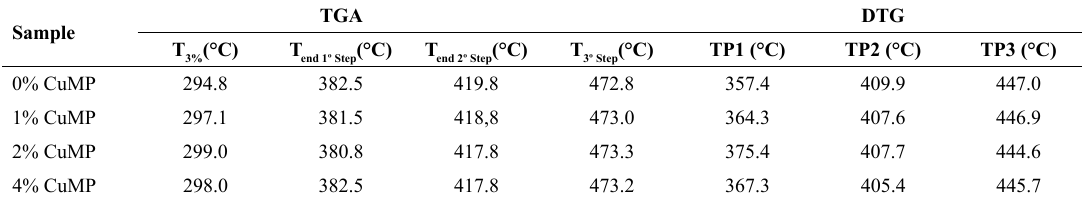
Table 2. TGA and DTG data of TPE compounds Sample